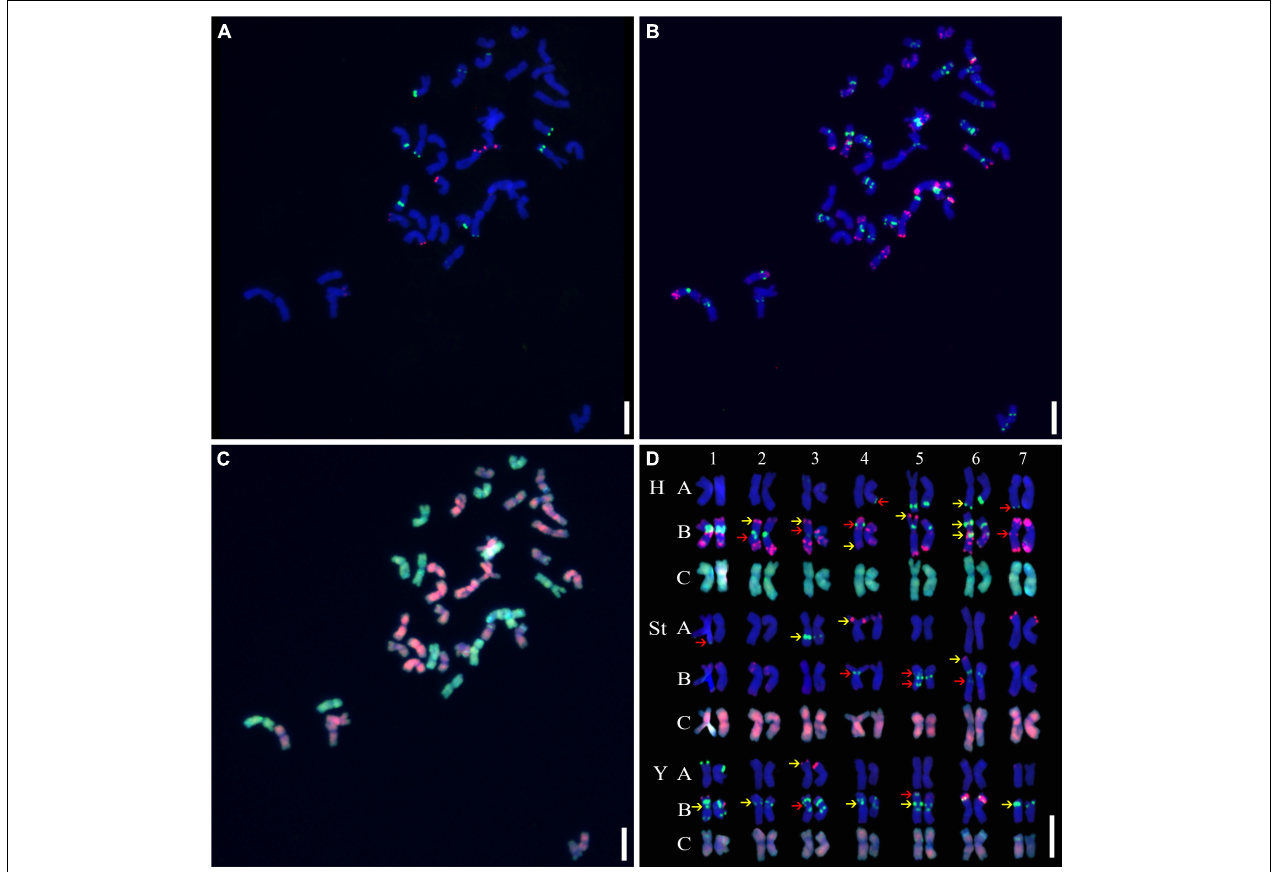
FIGURE 1 | Sequential fluorescence in situ hybridization (FISH) on mitotic chromosomes and karyotypes of plant A02-1 with repetitive sequence probes. (A) pTa71-2 (red) and pSc119.2 (green); (B) pAs1 (red) and (AAG) 10 (green); (C) genomic DNA probes of P. stipifolia (red); and H. bogdanii (green). (D) The molecular karyotype of A02-1 of E. nutans . Red arrows: the presence or absence of FISH signals between homologous chromosomes; yellow arrows: hybridization intensity discrepancies of FISH signals between homologous chromosomes. Bars = 10 µ m.